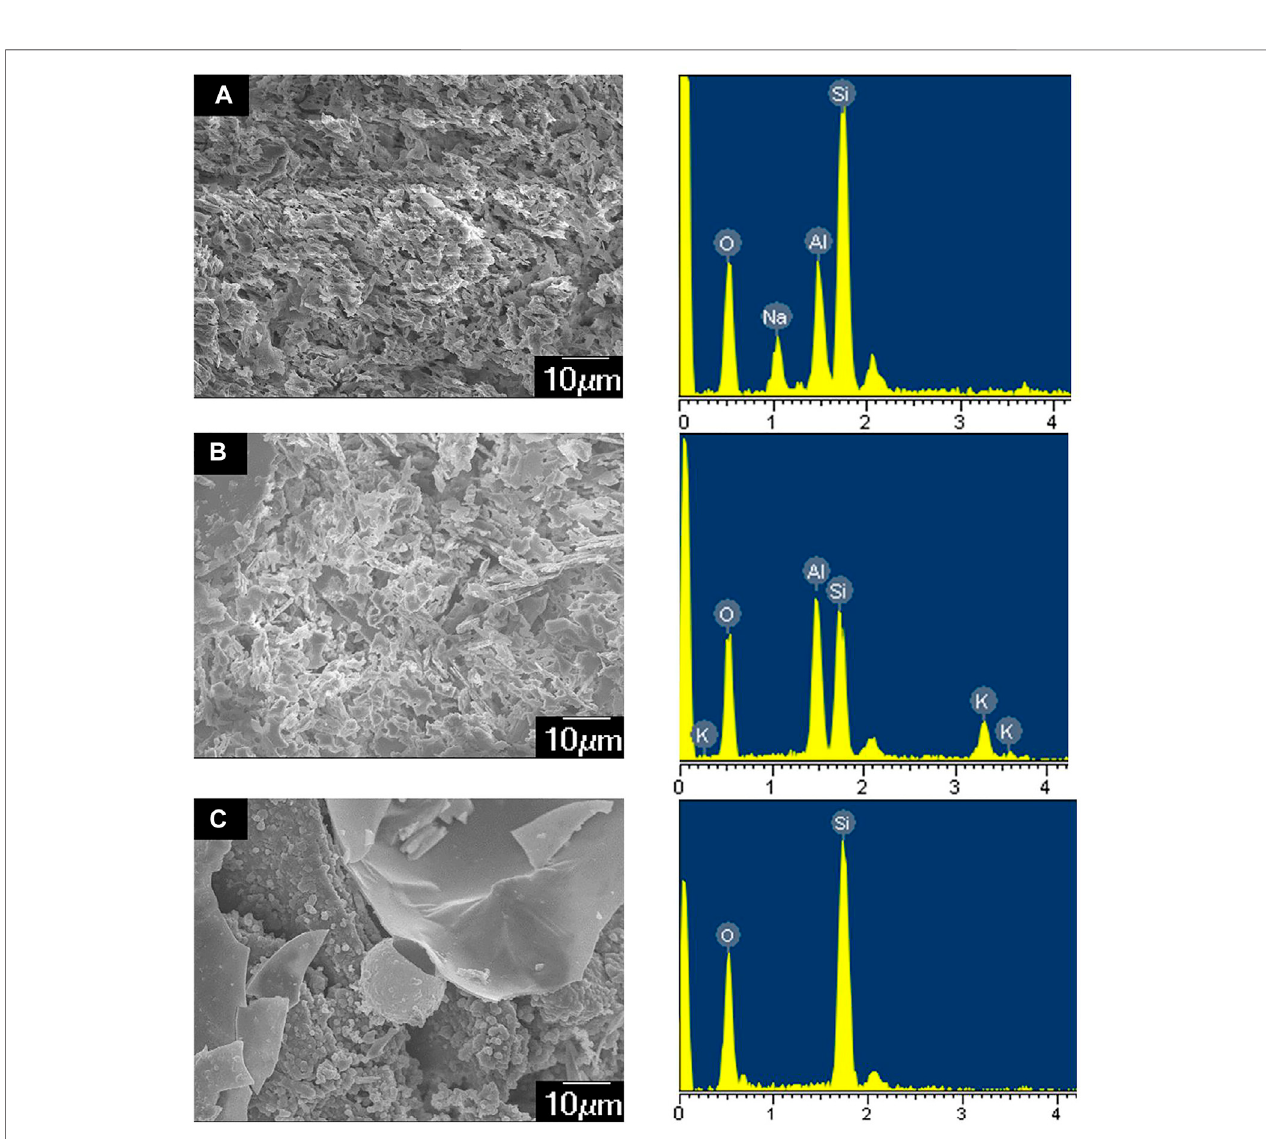
FIGURE 9 | SEM images of secondary precipitation. (A) Secondary plagioclase; (B) secondary potassium feldspar; (C) amorphous silica.